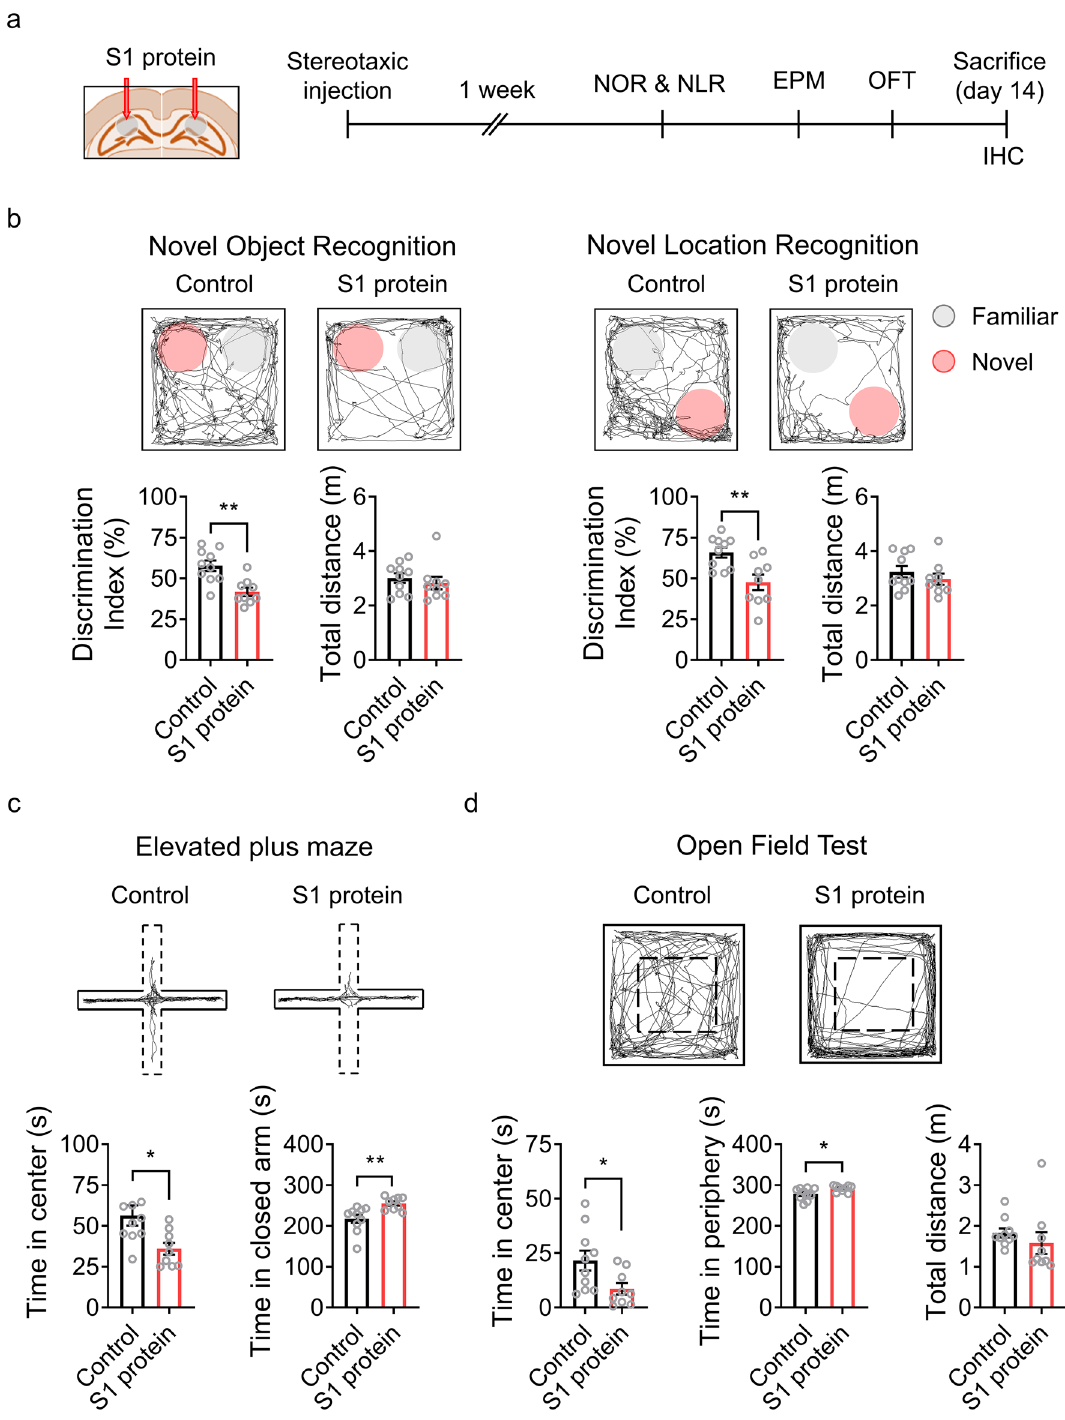
Figure 1. Administration of SARS-CoV-2 S1 protein induces cognitive deficit and anxiety-like behavior in mice. ( a ) Experimental design of S1 administration and behavioral tests. S1 protein (n = 10) or saline (Control, n = 10) was administered to C57BL/6 mice at 8 weeks of age, and behavioral tests were started 1 week after the administration. ( b ) Cognitive deficits were assessed using novel object recognition (NOR, left) or novel location recognition (NLR, right) tests and are presented as discrimination index percentages. Locomotor activity was measured by the total distance moved by mice in the chamber within a test session (bottom). The exploration time of a novel object or location divided by total exploration time was presented as the discrimination index of the novel object or location. The pink circle indicates a novel object or novel location. Anxiety-like behavior was assessed using the elevated plus maze test (EPM, panel c ) and the open field test (OFT, panel d ). ( c ) EPM trace of Control and S1 protein-injected groups (upper); the time spent in the open arm (dotted) vs. the closed arm (solid) in the EPM (bottom). ( d ) The center and periphery zones in the OFT are shown (upper). The time spent in the center vs. periphery zones in the OFT was examined (bottom). All representative navigations on the behavior test for a 5-min period are presented for the mice. The data are presented as the mean ± s.e.m. Statistical results are for unpaired t -tests. IHC, immunohistochemistry. ** p < 0.01, * p <